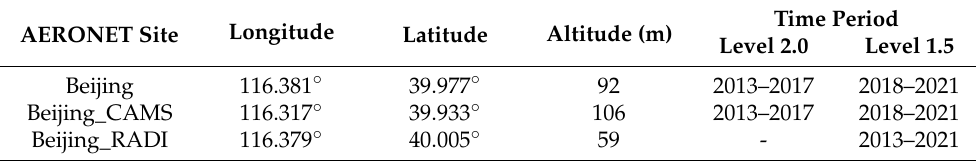
Table 1. AERONET AOD measurements were used in the present